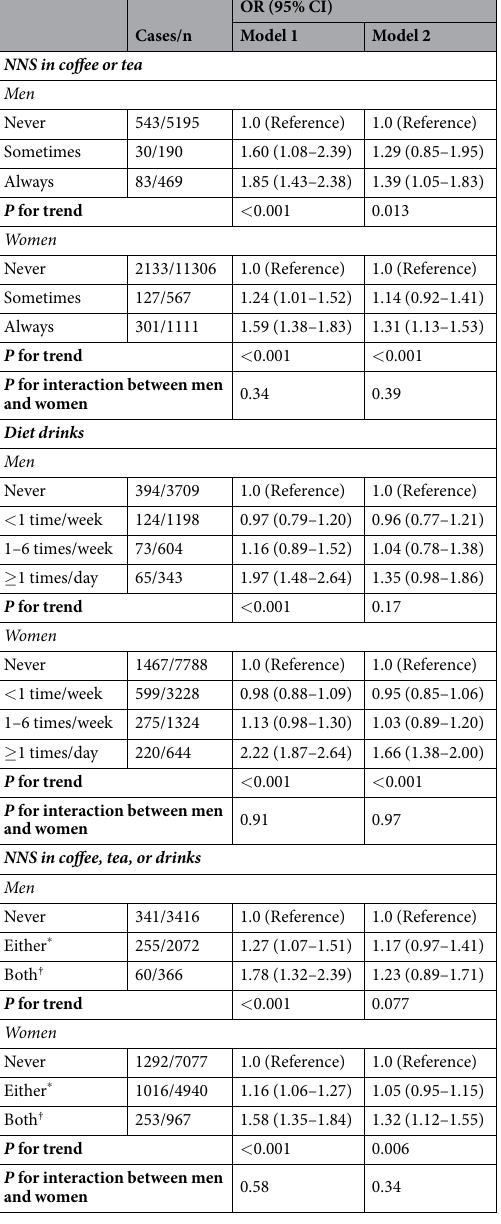
Table 4. Associations between non-nutritive sweeteners use and major depression risk among populations in Atlantic Canada. NNS = non-nutritive sweetener. Model 1, adjusted for age. Model 2, further adjusted for ethnicity, education, province of residence, smoking status, alcohol drinking, self-reported cardiovascular disease and diabetes, healthy eating index (in tertiles), total physical activity (in MET-min/week tertiles), and BMI based on model 1. * Either added non-nutritive sweetener in coffee or tea or drank diet drinks. † Both added non-nutritive sweetener in coffee or tea and drank diet